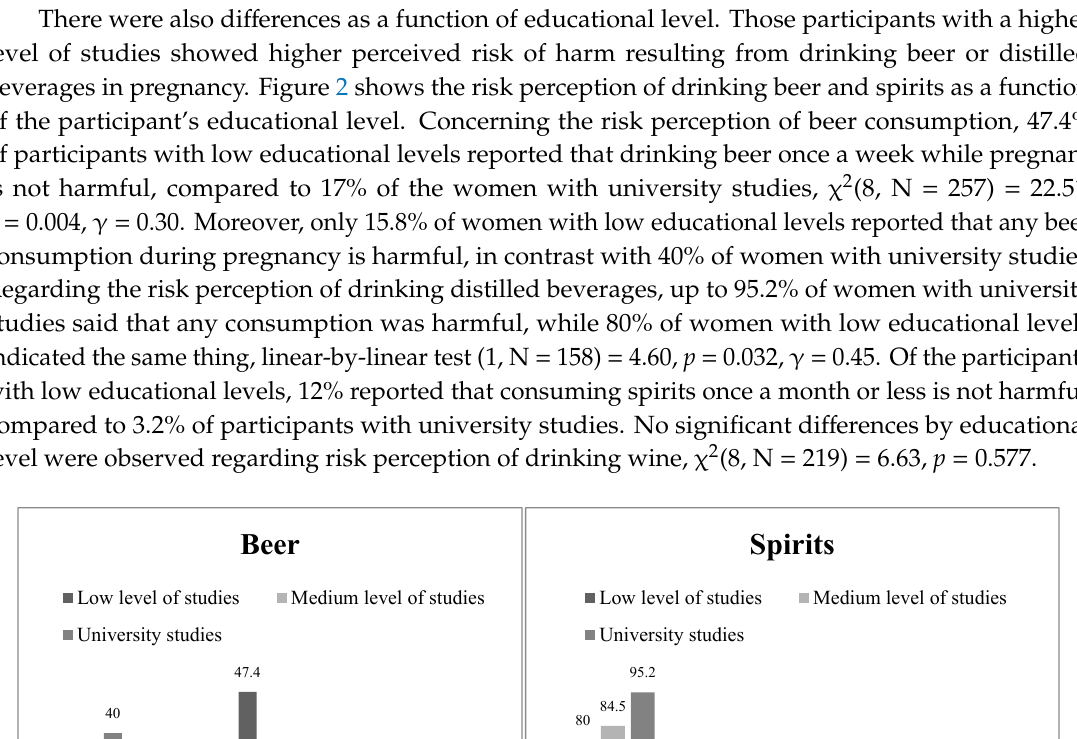
Figure 1. Risk perception of beer consumption in pregnancy by age.